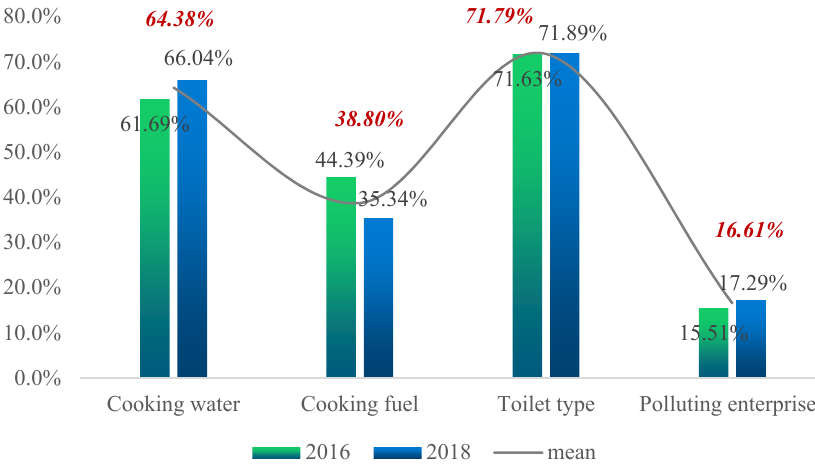
Figure 4. Proportion of the poor for each indicator of the healthy living environment dimension.